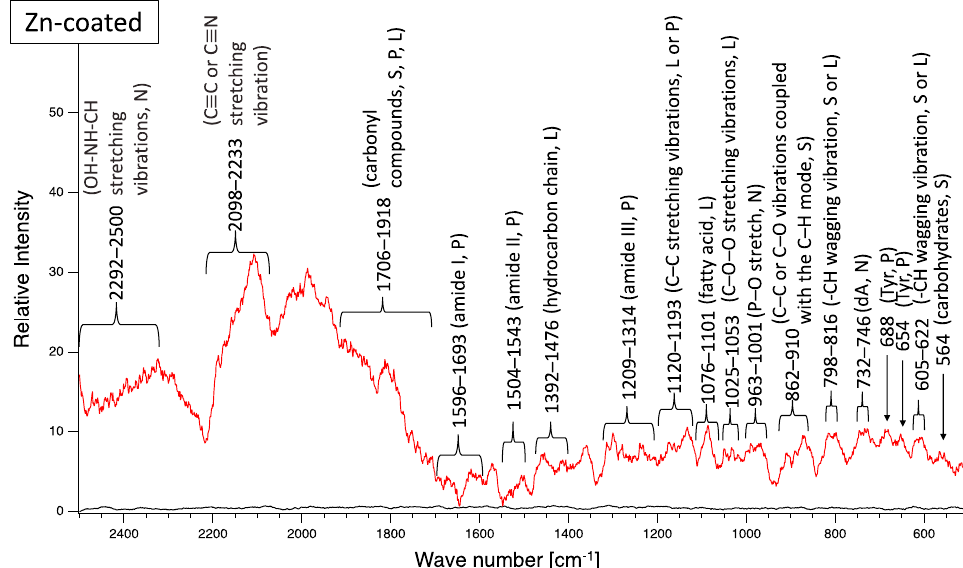
Figure 6. Raman peaks of sediments on the surface of the coupons following outdoor exposure testing (red line). Black lines show the Raman peaks of the surface of the specimens before the test. Detected Raman peaks after the test were assigned to related chemical bonds of compounds according to information in references [27–35]. N: nucleic acids; L: lipids; P: proteins; S: polysaccharides. Crystal violet staining is one of the methods used for biofilm biomass quantification [36]. The density of crystal violet staining was measured using a colorimeter, then the modulus of the combination of chromaticity value and brightness ( (cid:3493)(cid:4666)𝑎 ∗ (cid:4667) (cid:2870) + (cid:4666)𝑏 ∗ (cid:4667) (cid:2870) + (cid:4666)100 − 𝐿 ∗ (cid:4667) (cid:2870) ) was calculated. When a biofilm is stained using crystal violet, the color changes to violet and the transparence is lower (i.e., chromaticity of a* is positive value, that of b* is negative value, and brightness, L*, is lower than 100). If a biofilm becomes thicker (mature), (cid:3493)(cid:4666)𝑎 ∗ (cid:4667) (cid:2870) + (cid:4666)𝑏 ∗ (cid:4667) (cid:2870) + (cid:4666)100 − 𝐿 ∗ (cid:4667) (cid:2870) is larger. Therefore, the amounts of biofilms can be quantified using the value of (cid:3493)(cid:4666)𝑎 ∗ (cid:4667) (cid:2870) + (cid:4666)𝑏 ∗ (cid:4667) (cid:2870) + (cid:4666)100 − 𝐿 ∗ (cid:4667) (cid:2870) . The value for the Zn-coated coupons was significantly smaller than that of the SS400 coupons, the value for the Cu-coated coupons, however, was similar to that of the SS400 coupons (Figure 7). This result indicated that the Zn-coated coupons had a lower biofilm formation than the SS400 and Cu-coated coupons. Kanematsu et al. reported that Pseudomonas aeruginosa and Pseudoalteromonas carageenavara formed biofilms on the surface of SS400 much more than that of the other metal plated steels such as tin-, copper-, and zinc-plated ones, and iron (ion) could pull these bacteria better than other metals including tin, copper, and zinc [37]. In this study, iron oxide was detected on the surface of the coupons and that of the Cu-coated coupons after the outdoor exposure test (Figure 5), on the other hand, zinc oxide was detected on the surface of Zn-coated coupons. Therefore, it was probably that the surface of SS400 coupons and that of Cu-coated coupons were rich in iron (ions), but that of Zn- coated coupons was poor in iron, resulting in the difference of biofilm formation among these coupons.